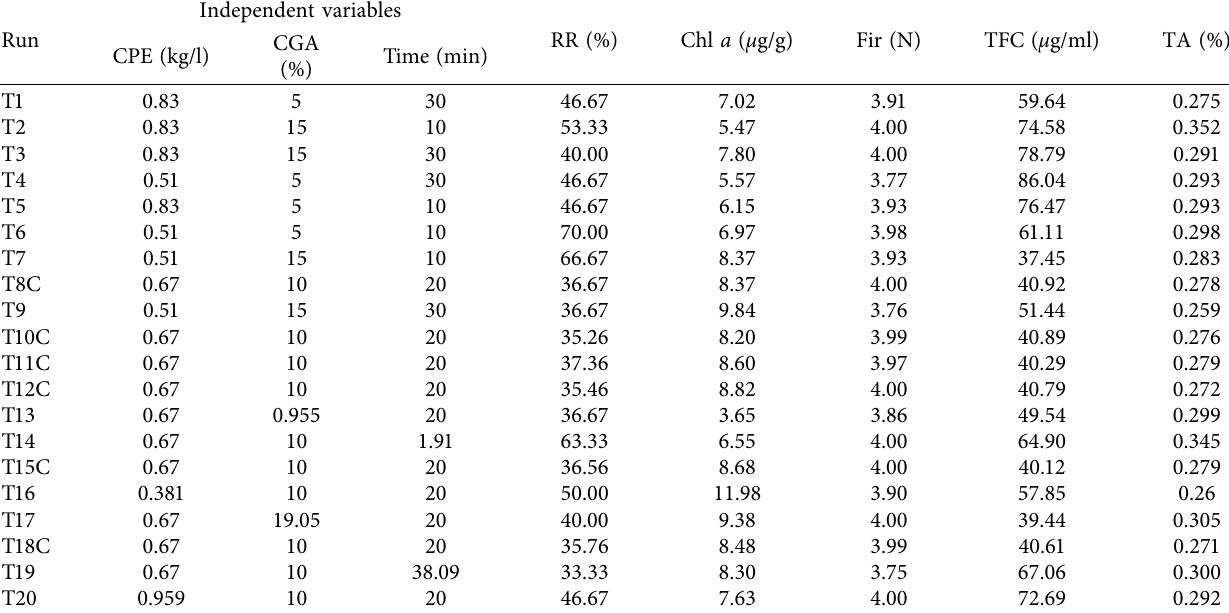
Table 1: Center composite design (CCD) and experimental data obtained for the response variables studied. Run